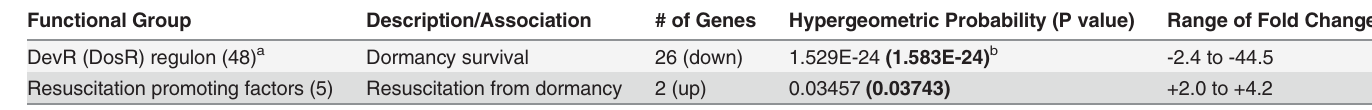
Table 2. Differentially expressed functional categories indicative of M . tb active state in type II AEC. Functional Group